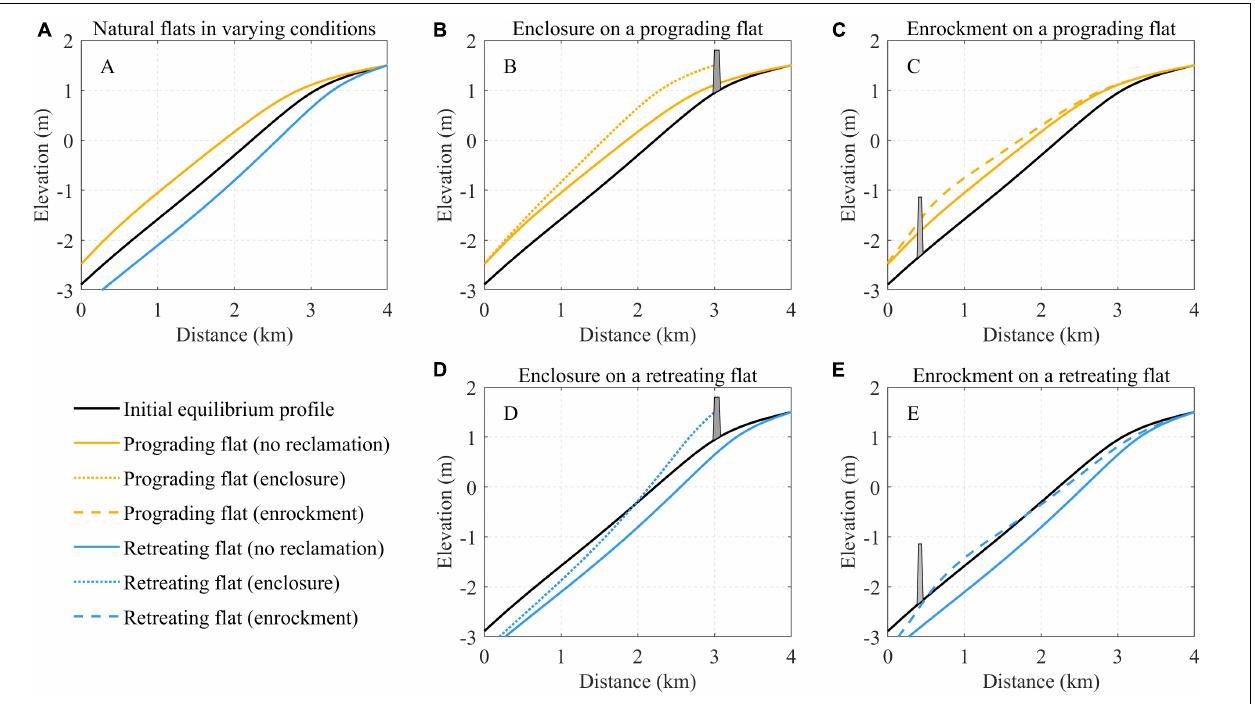
FIGURE 4 | Tidal flat profiles under various situations. (A) Natural profiles in progradation, equilibrium, and retreat. (B,C) Reclamation on a prograding flat. (D,E) Reclamation on a retreating flat. The initial equilibrium profile is the same as in Figure 3